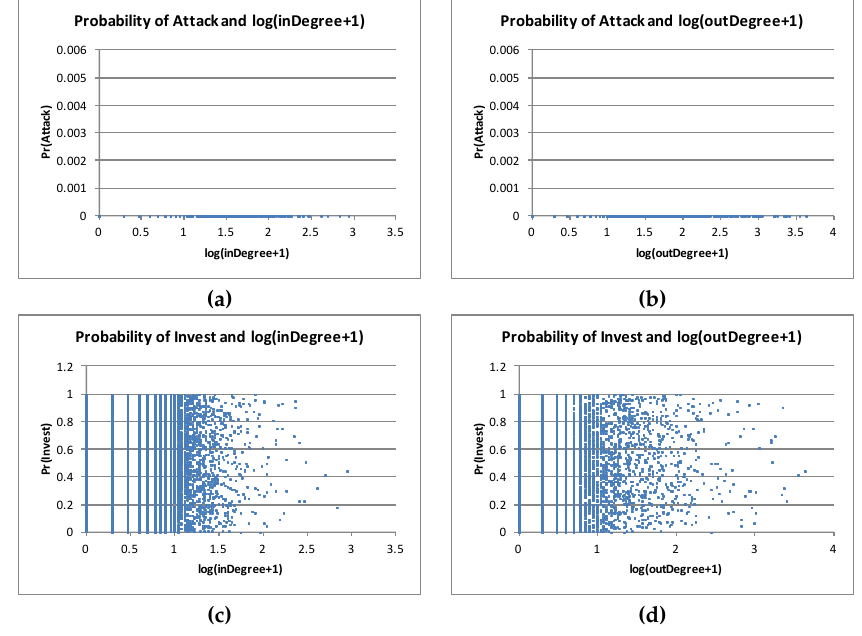
Figure 11. The Degrees and Strategies of Sites Not Directly Targeted. These are plots on the remaining 26,704 nodes with zero y i . The two graphs on top, ( a ) and ( b ), show the corresponding y i ( y -axis) and its indegree and outdegree in logarithmic (base 10) scale. Similarly, the two graphs at the bottom, ( c ) and ( d ), show the corresponding x i ( y -axis) and its indegree and outdegree in logarithmic (base 10)